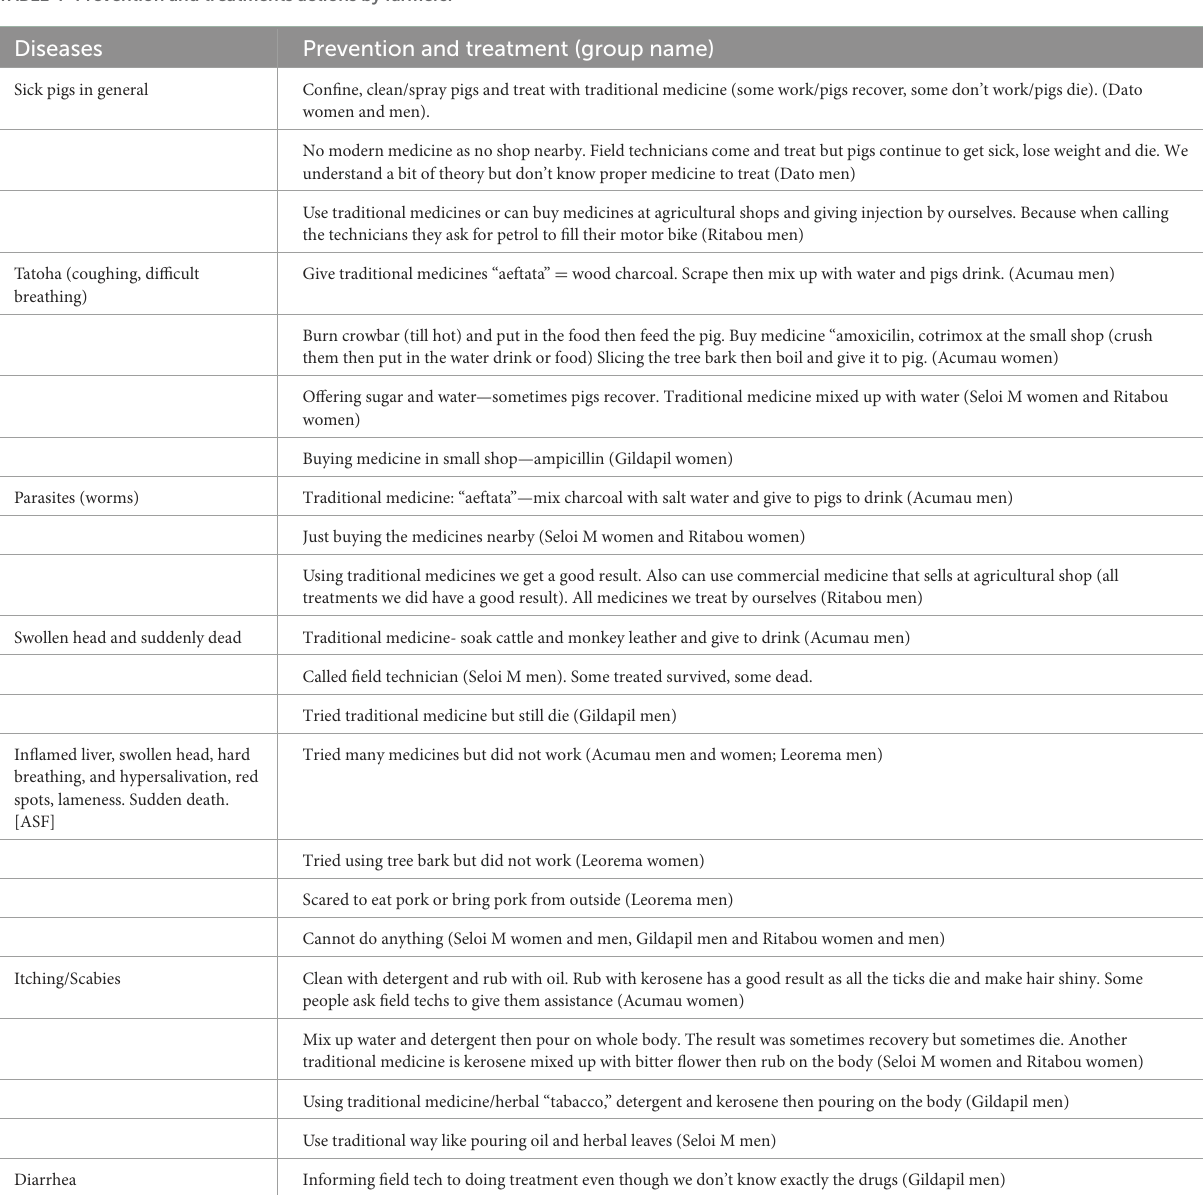
TABLE 4 Prevention and treatments actions by farmers. Diseases Prevention and treatment (group